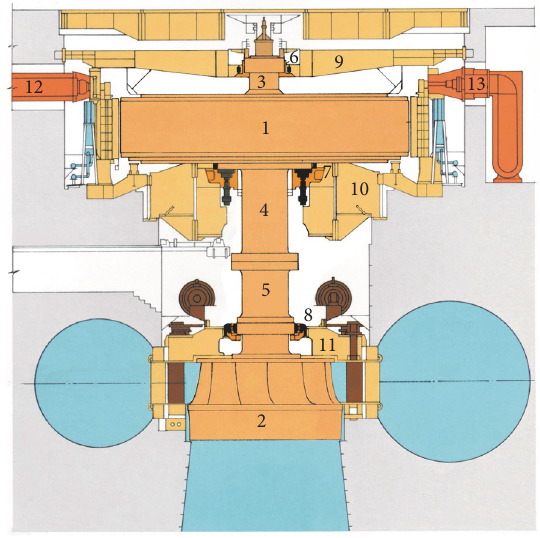
Figure 1: View of Itaipu Power Plant hydrogenerators.